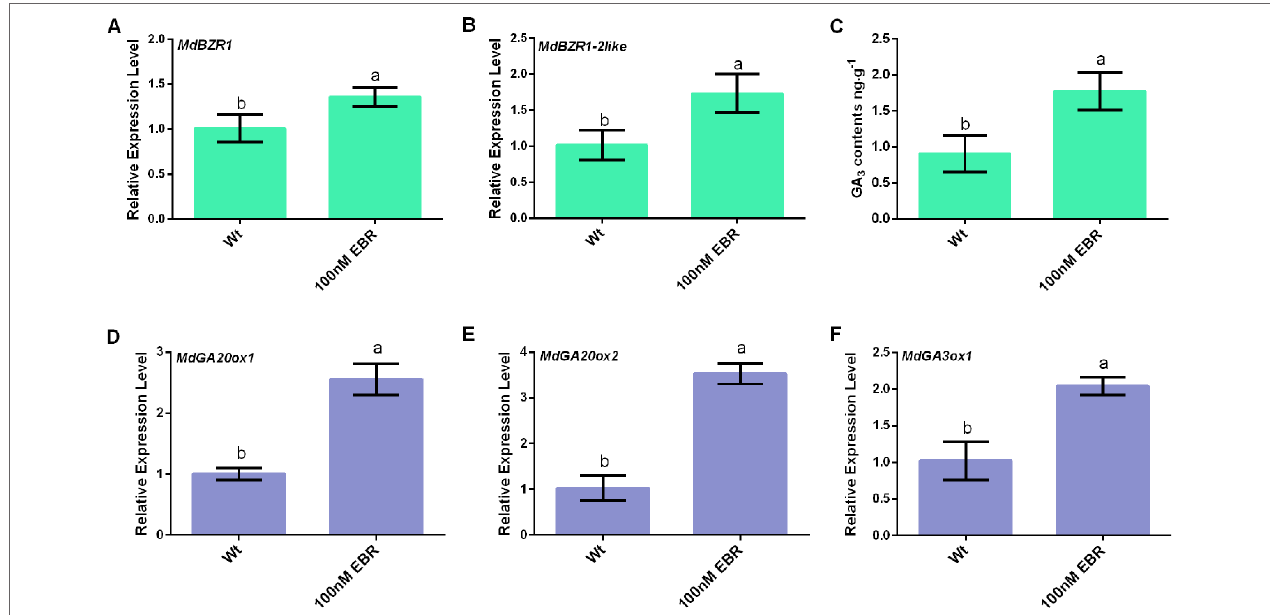
FIGURe 1 | BR signaling associate with the upregulation of MdGA20ox1 , MdGA20ox2 , and MdGA3ox1 . (A) MdBZR1 relative expression level. (B) MdBZR1-2like relative expression level. (C) GA 3 contents. (D – F) MdGA20ox1 , MdGA20ox2 , and MdGA3ox1 relative expression levels. Data are shown as mean ± SE of three independent replicates. Different letters indicate significant differences at p